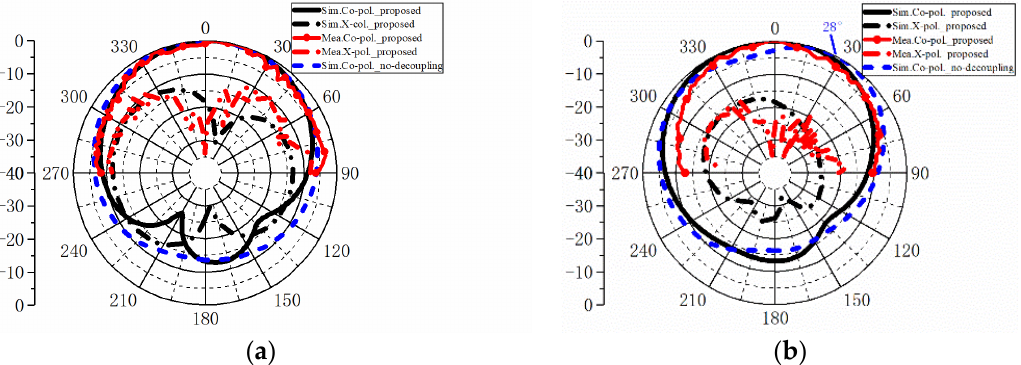
Figure 8. Pattern comparisons between the simulation and measurement: ( a ) E-plane and ( b ) H-plane.